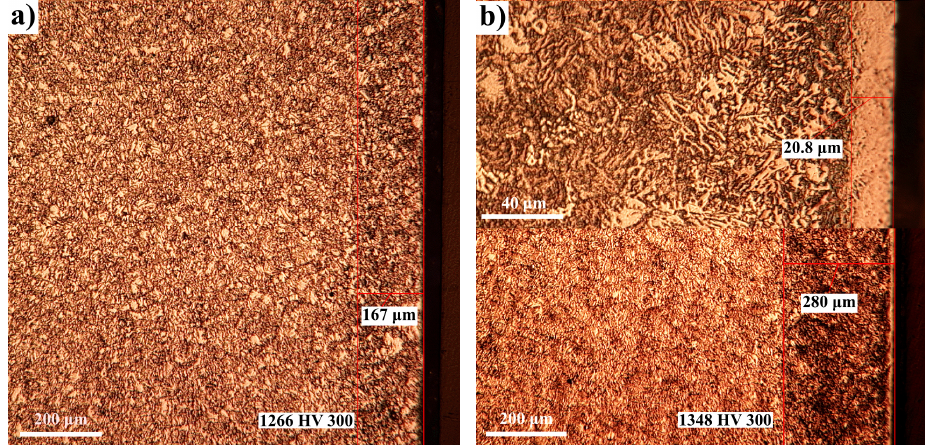
Figure 8. OM images of 34CrAlMo5 nitralloy steel nitrided to various temperatures: 540 ◦ C ( a ) and 620 ◦ C ( b ) in atmosphere of partially dissociated ammonia, α NH 3 = 45%, diluted with 60% N 2 ; potential of nitrogen 1.9; nitrogen concentrations in superficial areas of layers: 8.3% ( a ) and 8.9% ( b ). The microhardness indentations were performed at 150 microns from the surface of the layer.